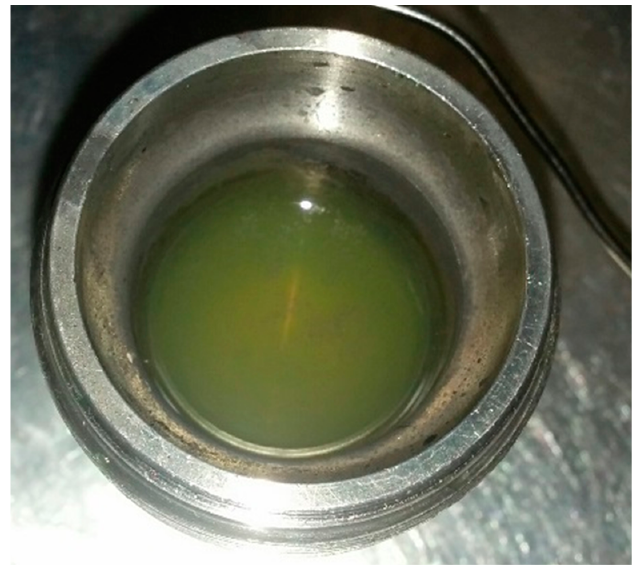
Figure 4. Glycol appearance inside the autoclave cell after the O-ring failure.